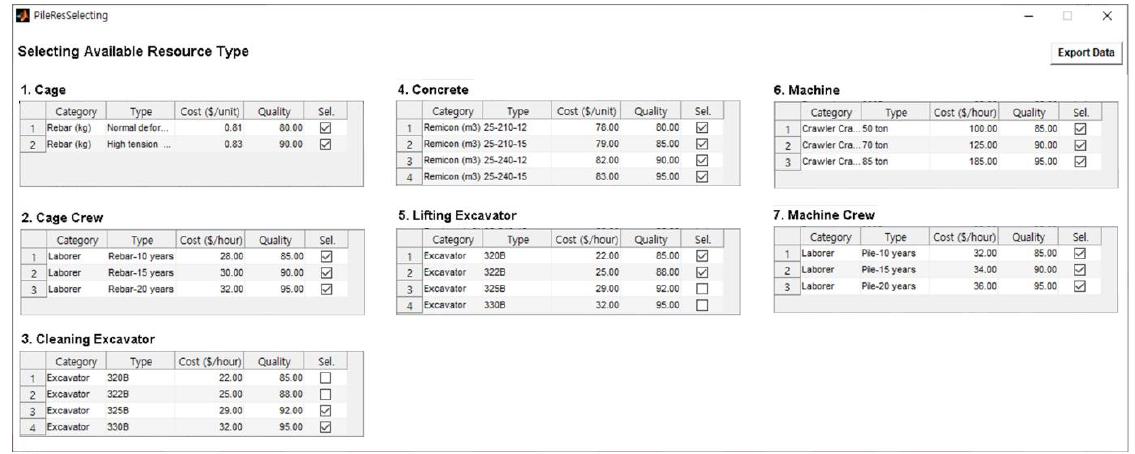
Figure 4. Graphic user interface for sensitivity analysis and simulation results.